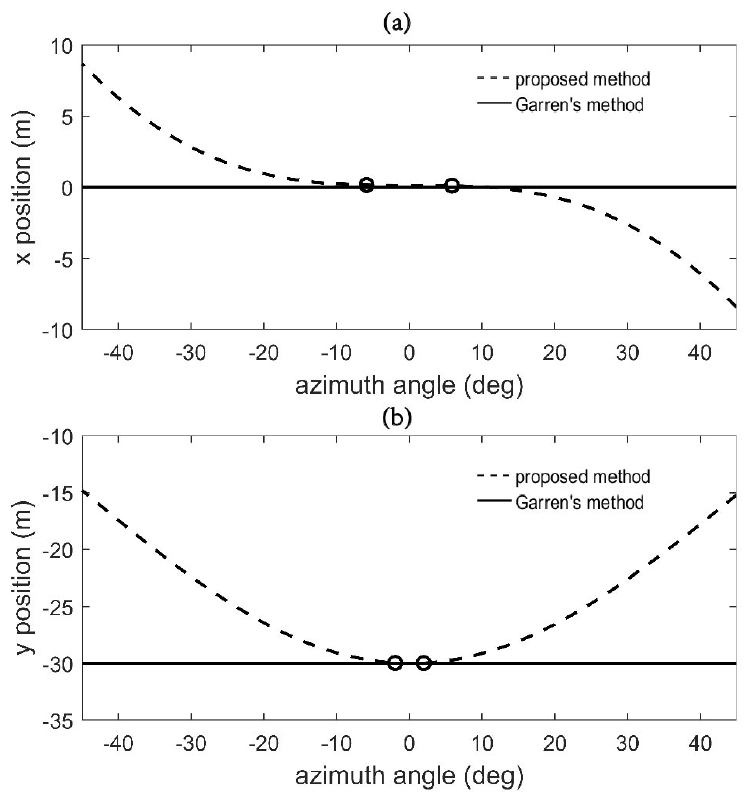
Figure 29. The ( a ) and ( b ) are x , y components of image traces predicted by two models versus azimuth viewing angle